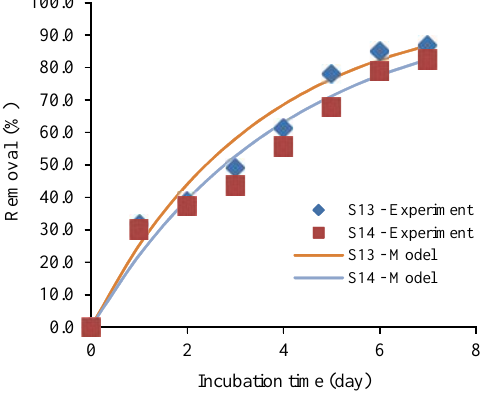
Fig. 6(c): Comparison of experimental and model values by A. fumigatus Fig. 6(d): Comparison of experimental and model values by A.